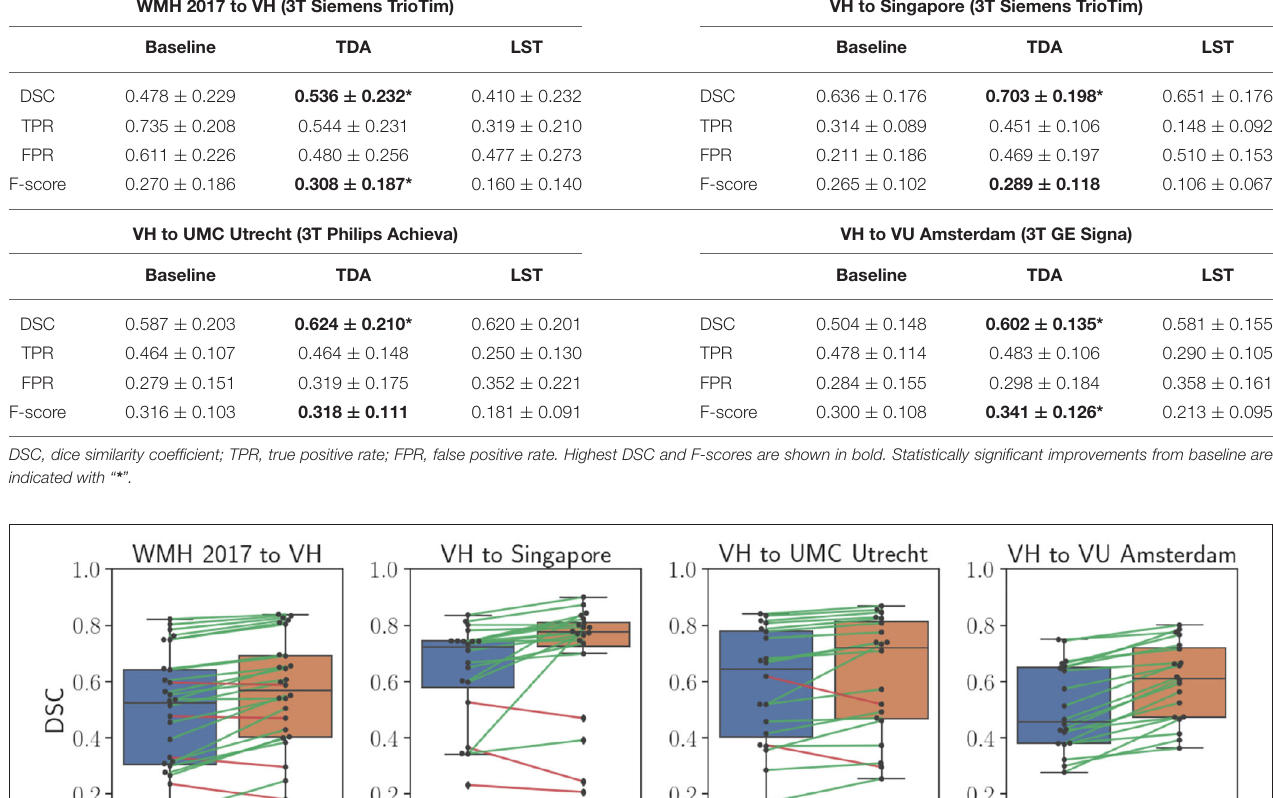
TABLE 2 | WMH lesion segmentation results for the pre-trained baseline model without domain adaptation, transductive domain adaptation (TDA), and unsupervised LST method for four different sites: (1) source WMH 2017 and VH target; (2) source VH to Singapore; (3) source VH to UMC Utrecht; and (4) source VH to VU Amsterdam. WMH 2017 to VH (3T Siemens TrioTim)